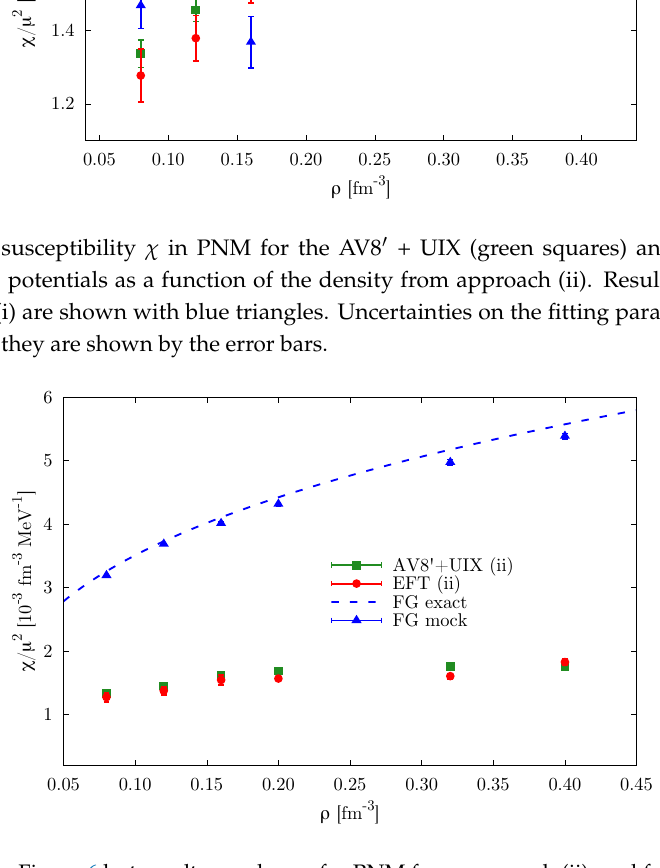
Figure 7. Same as Figure 6 but results are shown for PNM from approach (ii), and for the free FG from analytic solution (blue dashed line) and based on mock data (blue triangles), see Figure